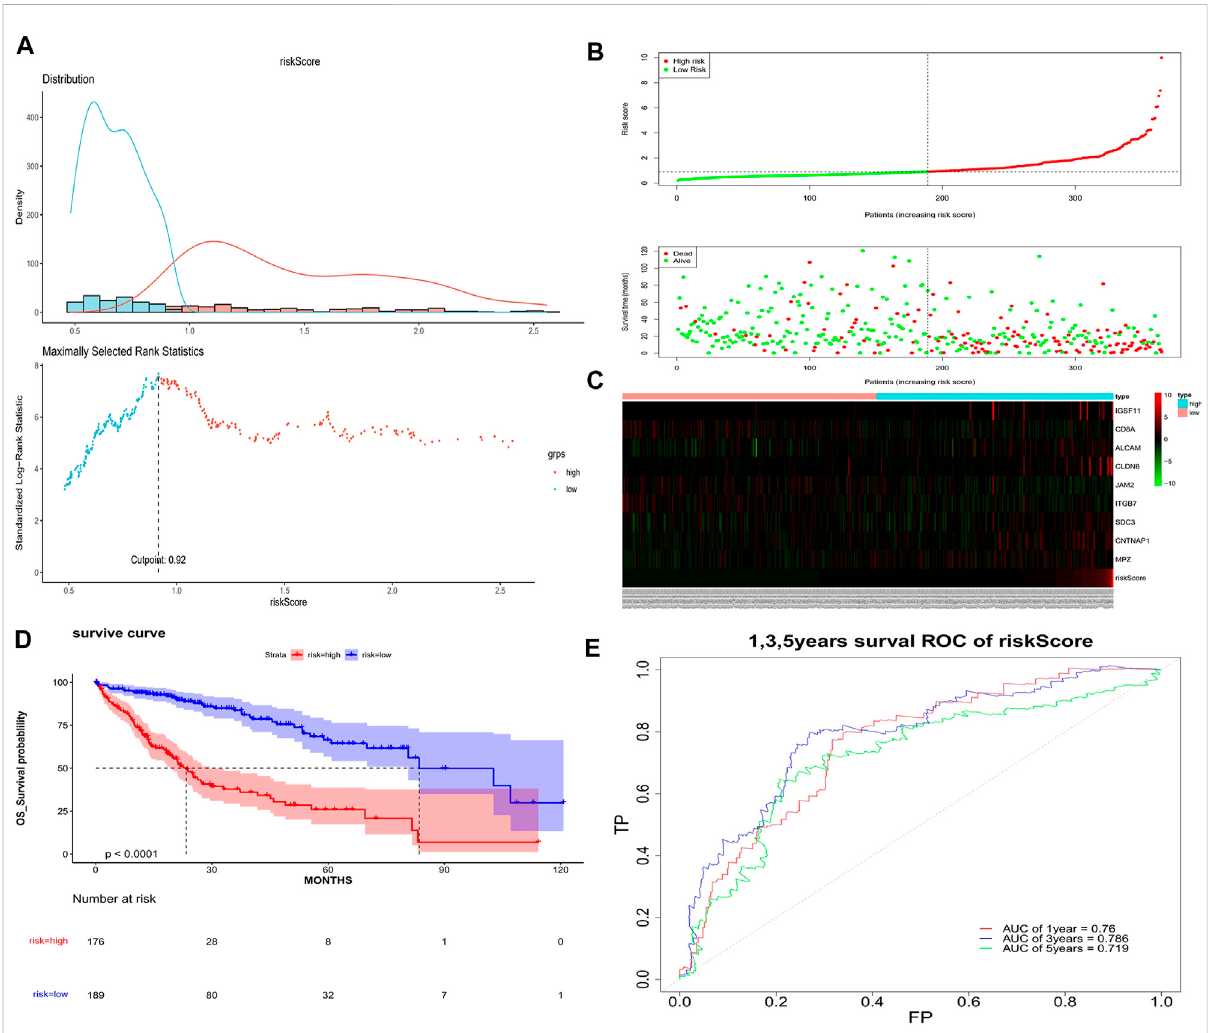
FIGURE 5 Assessmentoftheriskmodel. (A) Optimalthresholdscreeningforriskdistributioninthetrainingset. (B) Theriskscore,survivaltimeofpatientsin the training set. (C) The expression of model genes in the training set. (D) Survival curve of high- and low-risk patients in the training set. (E) ROC curves of the risk model in the training